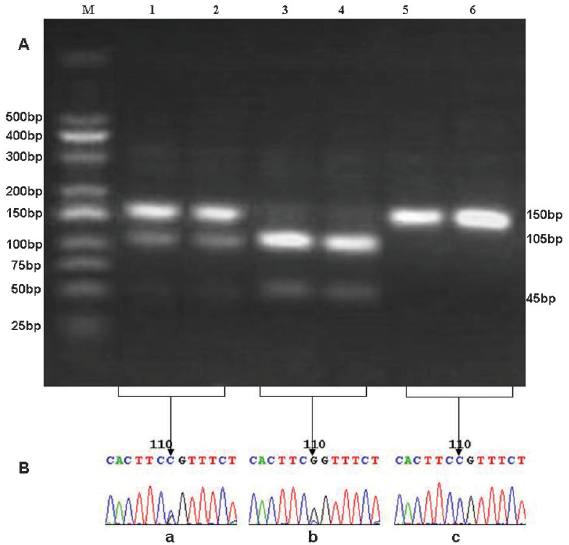
Figure 2. Genotypes of the ELOVL6 single nucleotide poly- morphism (SNP) rs17041272. A , Restriction fragment length polymorphism analyses for determination of the rs17041272 genotype (digested by Msp I). The GC genotype shows 3 bands of 150, 105, and 45 bp ( lanes 1 and 2 ), the GG genotype shows 2 bands of 105 and 45 bp ( lanes 3 and 4 ), and the CC genotype shows a band of 150 bp ( lanes 5 and 6 ). B , Nucleotide sequences surrounding the SNP rs17041272. a , GC genotype; b , GG genotype; c , CC genotype. Lane M : DNA marker.